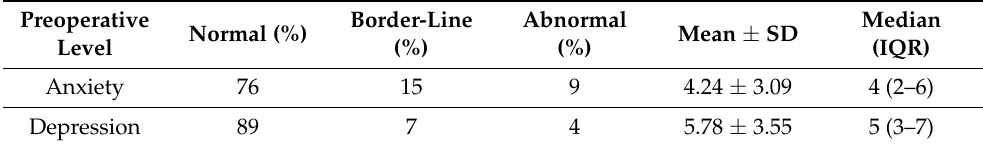
Table 2. Sample’s level of preoperative anxiety and